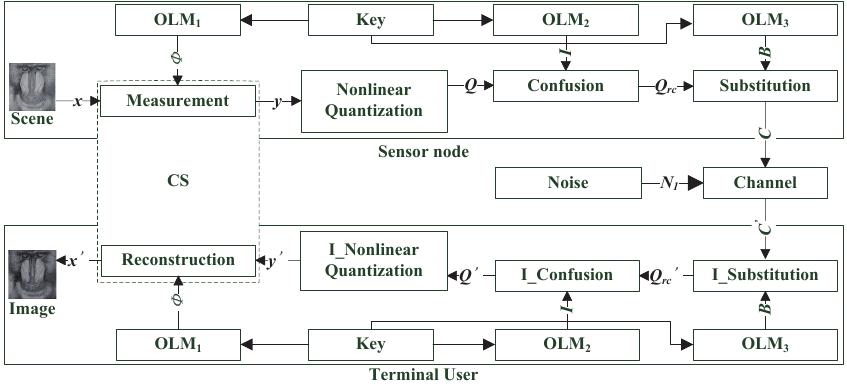
Figure 3. The framework of the proposed